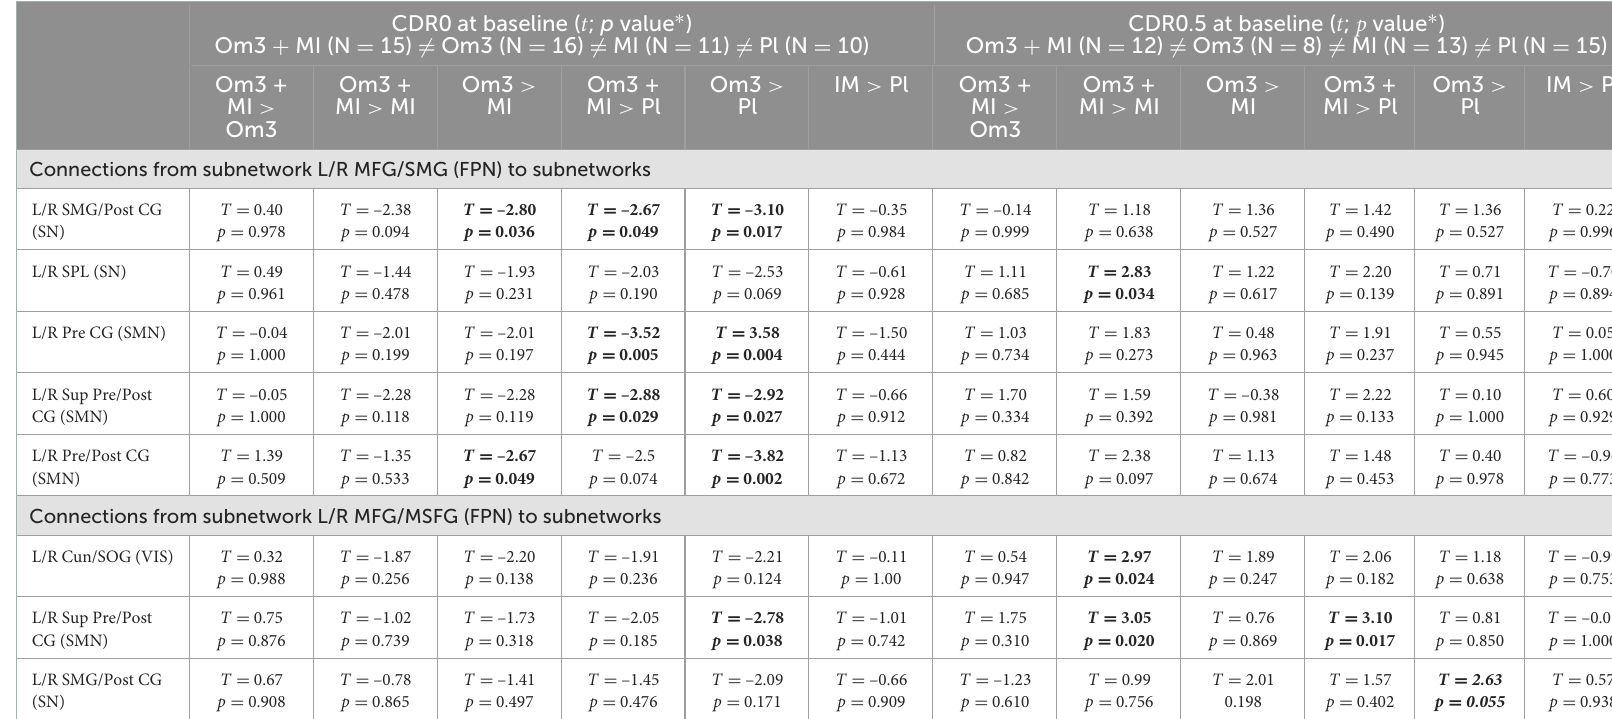
TABLE 3 Post hoc tests on significant connections between subnetworks (main networks) for interaction intervention group × baseline CDR status ×